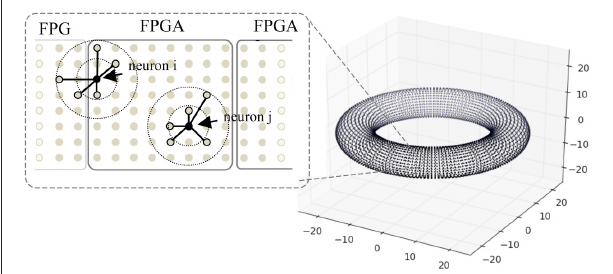
FIGURE 8 | A toroidal neuronal network. Each dot represents the position of a neuron. Synaptic connection probability depends on the distance between the neurons which has a Gaussian distribution. Dotted circles denote connection probability within 1 and 2S.D. One FPGA handles the computation of 98,304